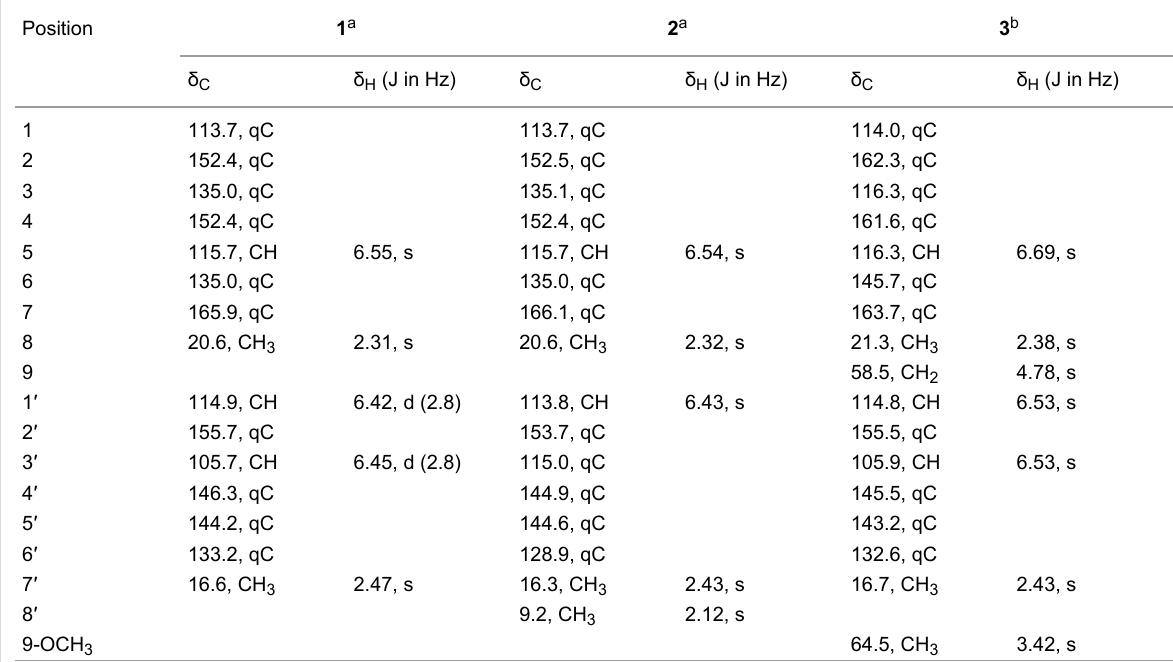
Table 1: 1 H and 13 C NMR spectroscopic data for compounds 1 – 3 .